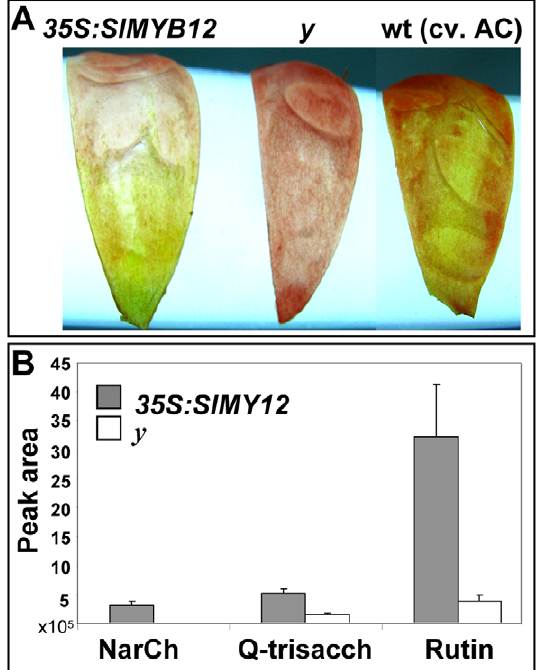
Figure 10. Sectorial phenotype complementation in a trans- genic y line constitutively expressing the SlMYB12 gene under the 35S CaMV promoter ( 35S:SlMYB12 ). (A) Peels of red fruit from the 35S:SlMYB12 line on a y background, the y mutant and wt cv. AC. (B) UPLC-PDA analysis of red fruit peels reveals significantly different levels of flavanoids between regions of phenotype complementation in peels of the 35S:SlMYB12 line and those of the y mutant (n=3; P , 0.01; bars represent standard error). The UPLC instrument used in this analysis is equipped with an Acquity 2996 PDA detector. Sample preparation and LC conditions were as described for the UPLC-QTOF-MS analysis. Compounds peak areas were determined by Empower 2 software (Waters) at 370 nm for naringenin chalcone (NarCh) and at 256 nm